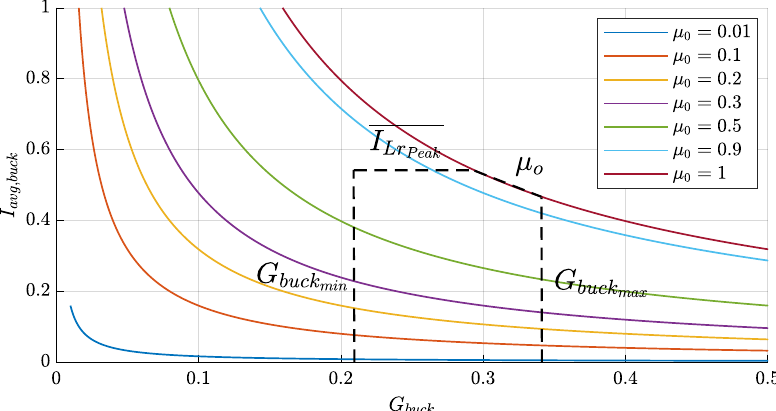
Figure 11. Current, gain, and switching frequency: limits in buck